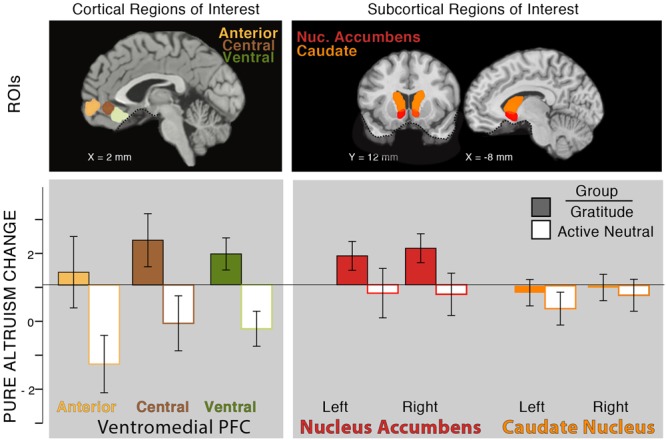
Effect of intervention on neural pure altruism in seven a priori ROIs implicated in previous research (Hubbard et al., 2016). The insets show the locations of the ROIs: VMPFC ROIs (left panel) are those reported in Clithero and Rangel (2014). Subcortical ROIs (right panel) are Harvard Oxford atlas locations at a threshold of 30%. The dashed line in ventral regions of the brain shows the limit of our sampling of the brain due to magnetic susceptibility artifacts. Neural pure altruism is operationalized as the contrast between the neural response to charity-gains versus self-gains for mandatory transfers of money; the Y-axis represents the change in neural pure altruism from pre-test to post-test. The group of participants who completed 3 weeks of gratitude journaling (colored bars) showed an overall increase in the neural pure altruism measure relative to the active-neutral journaling group (white bars) in the VMPFC.